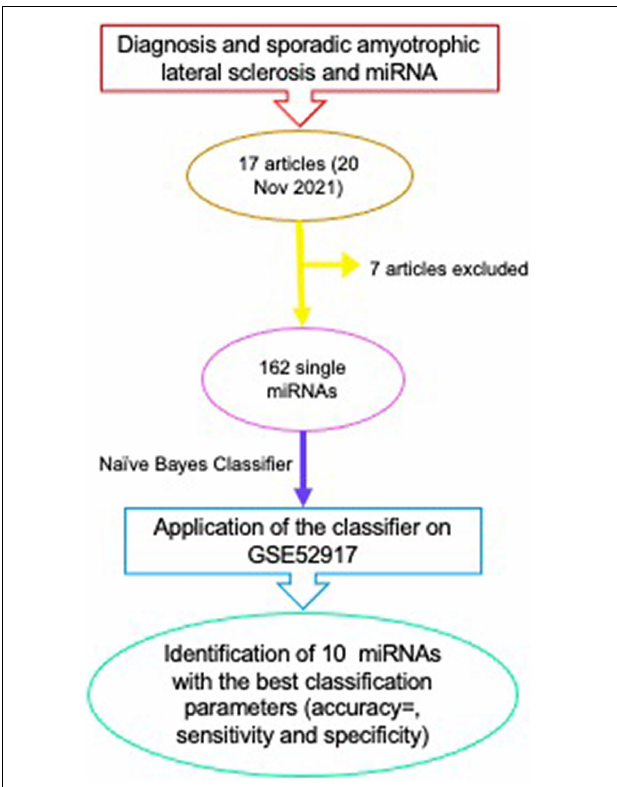
FIGURE 2 | Scheme of the method for identification of a panel of miRNAs with diagnostic properties in